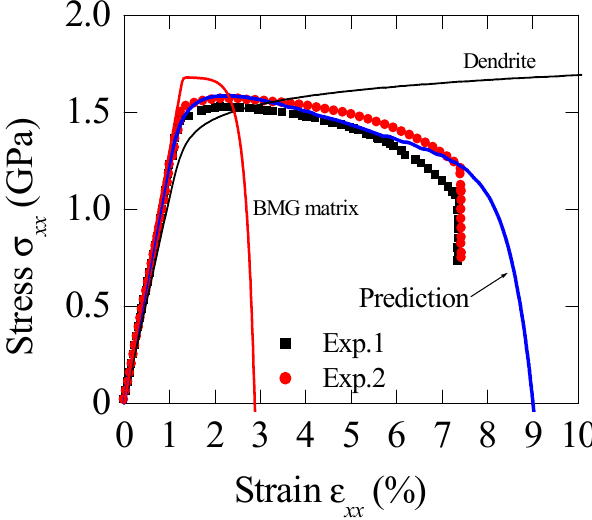
Figure 3. Comparisons of the macroscopic stress–strain relations between the prediction and experiments for BMGCs with particle volume fraction of 43% [19]. ε 0 = 0.1 and m = 16 are adopted in the computation.